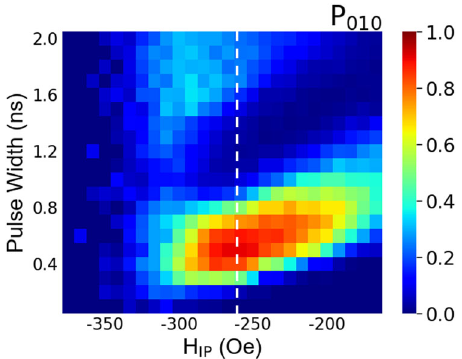
Fig. 2 Switching phase diagram for a 70 nm device. Measured probability of back and forth switching (i.e., two successful consecutive switching attempts) for a 0.9 V nominal voltage pulse under different pulse widths and in-plane magnetic fi elds applied to a 70 nm device. The dashed white line indicates the in-plane magnetic fi eld that was used for the subsequent switching probability measurements as a function of voltage pulse amplitude and width, shown in Fig.